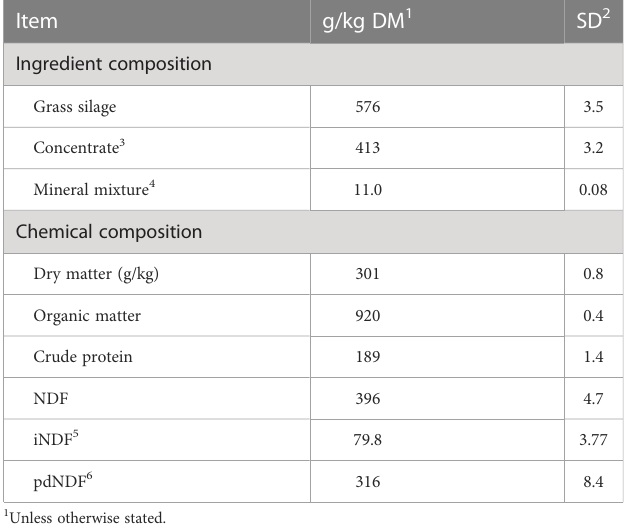
(Table 6) Total VFA decreased ( p = 0.03) when AT was included in the diets. Molar proportions of individual VFAs were altered ( p ≤